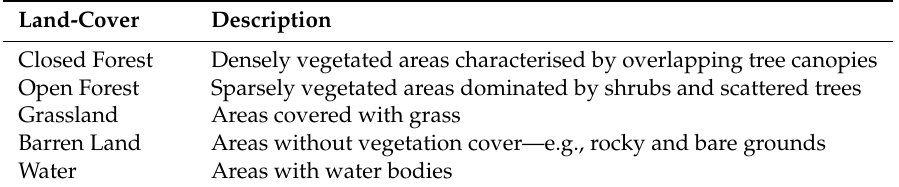
Table 2. Land-cover classification scheme.